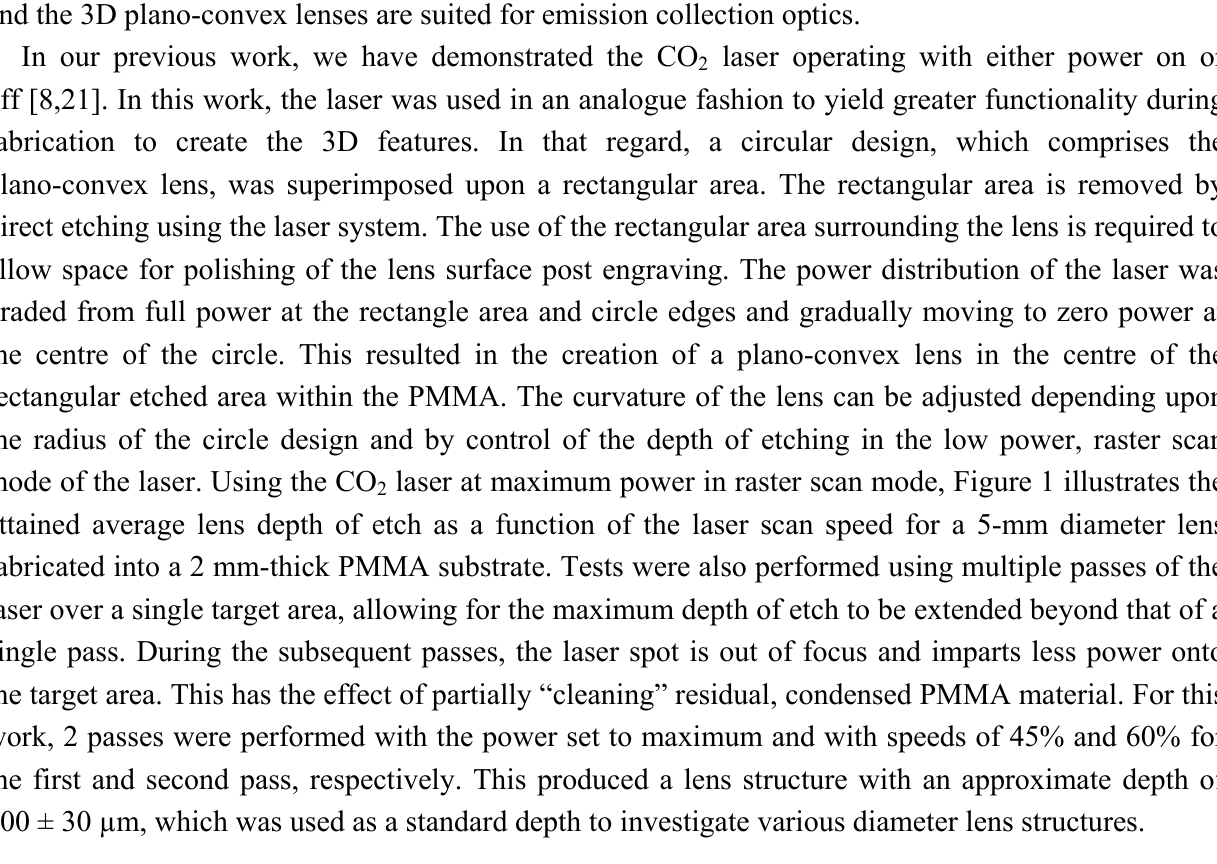
Figure 1. Ablation depth as a function of laser scan speed for maximum raster mode laser